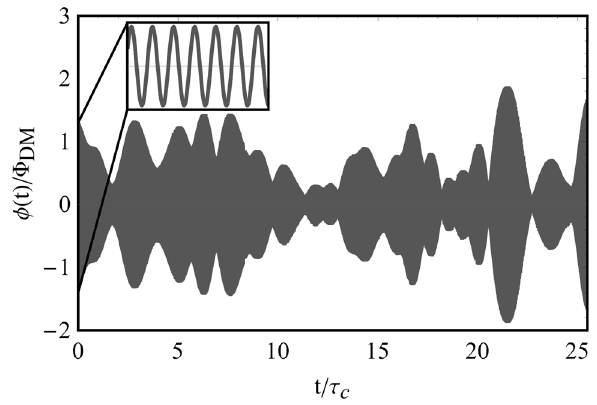
Fig. 1 Simulated VULF based on the approach in ref. 28 with fi eld value ϕ ( t ) and time normalized by Φ τ DM and coherence time c , respectively. The inset plot displays the high-resolution coherent oscillation starting at t =